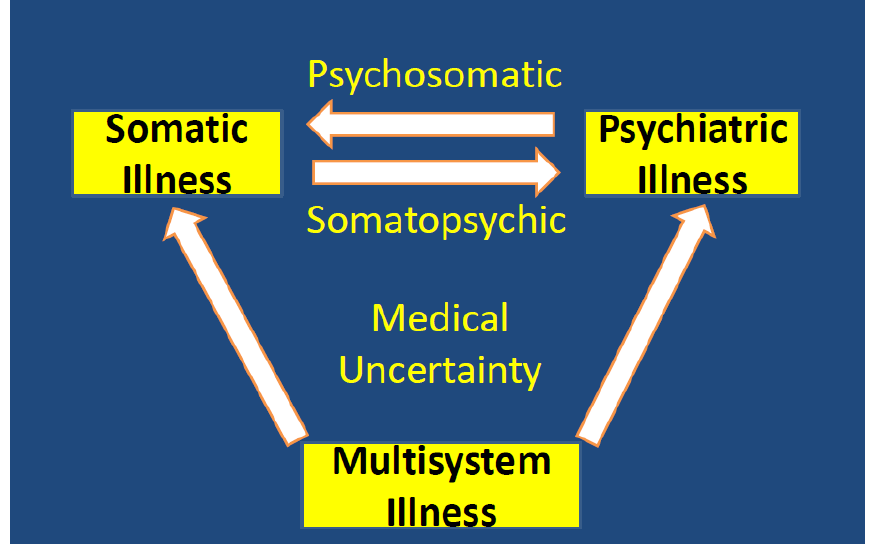
Figure 1. The relationship between psychosomatic, somatopsychic, multi system illness, and medical uncertainty.